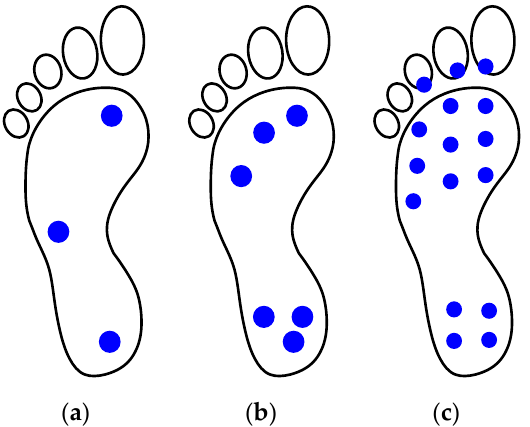
Figure 2. Solutions of pressure sensor deployment on the footprint for static assessment: ( a ) three sensors deployed onto the forefoot, midfoot and heel [8], ( b ) three sensors for the forefoot and heel respectively—this solution was also employed in walking tests [6], and ( c ) sensor arrays deployed on the forefoot and heel to estimate centers of pressure—this solution was also employed in training room exercise tests [9].